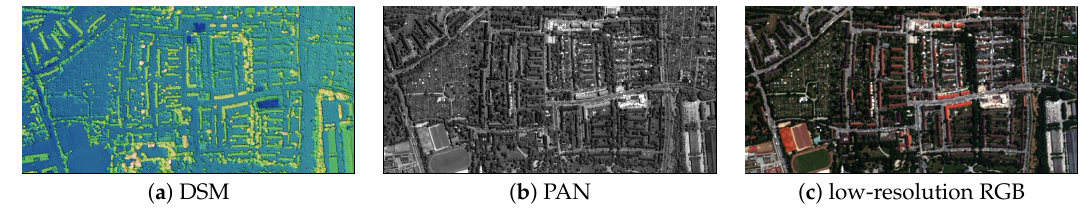
Figure 4. Test area in Munich, Germany. DSM image is color-shaded for better visualization.